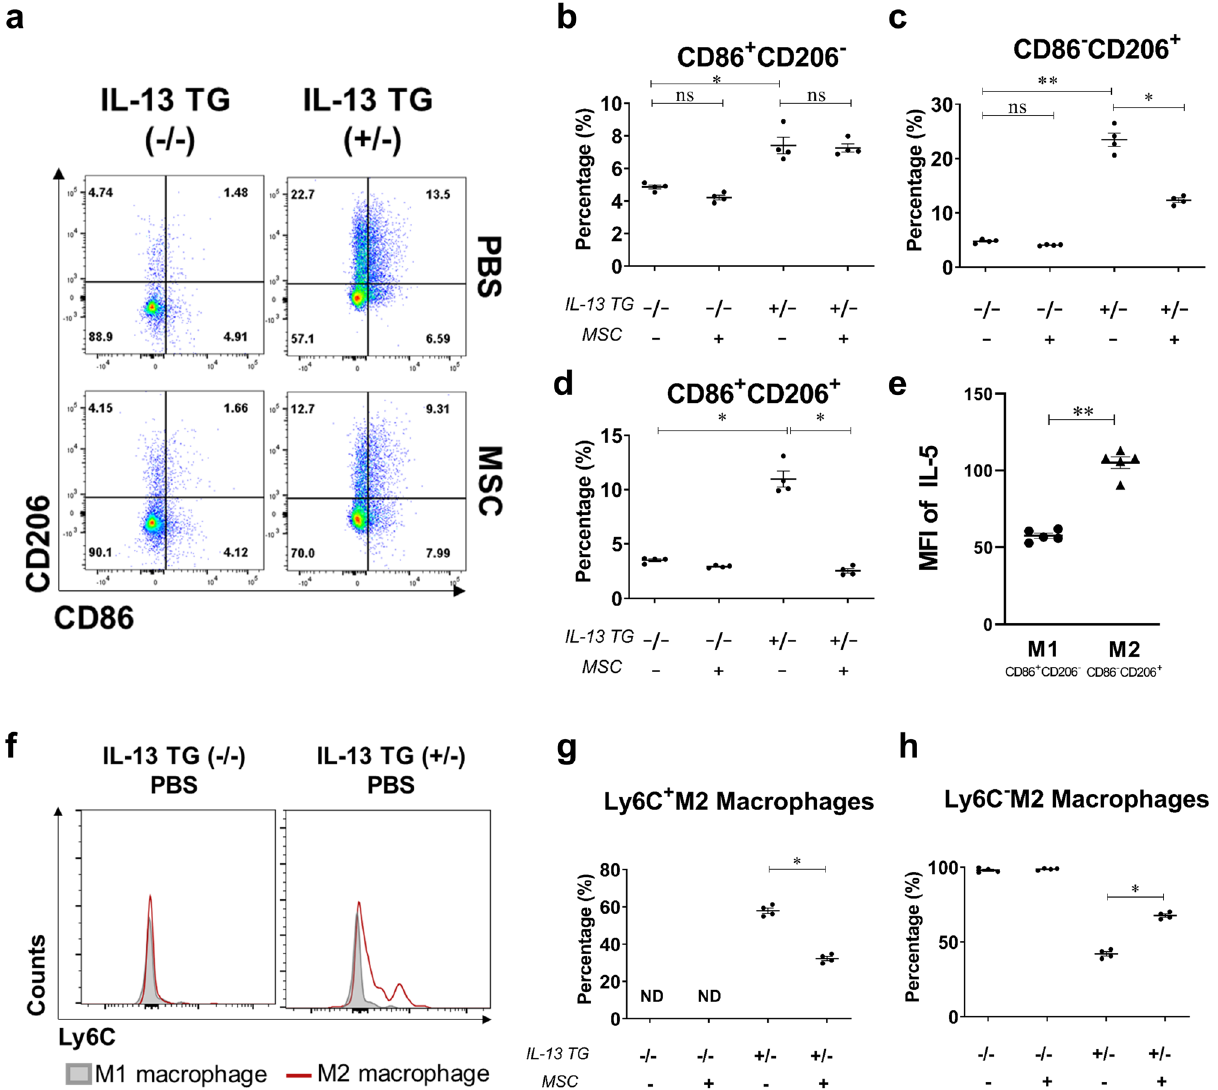
Figure 4. Ly6C + M2 macrophages are key mediators of asthmatic phenotypes. ( a ) Flow cytometric data on M1 and M2 macrophages of CD11c + CD11b + macrophages. The percentages of CD86 + CD206 − M1 ( b ), CD86 − CD206 + M2 macrophages ( c ), and CD86 + CD206 + macrophages ( d ) are represented in scatter plots. ( e ) the MFI of IL-5 in CD86 + CD206 − M1 and CD86 − CD206 + M2 macrophages in IL-13 TG mice. ( f ) Shows Ly6C expression levels in M1 and M2 macrophages of WT and IL-13 TG mice. ( g , h ) shows the ratio of Ly6C + M2 and LY6C − M2 macrophage populations among the CD11c + CD11b + macrophages. Flow cytometry data were analyzed by the FlowJo Software v10.6, https:// www. flowjo. com. Each value in these panels is from a different individual and the mean ± SEM are illustrated. All results are representative of at least three independent experiments. *p < 0.05, **p < 0.01, ns not significant. (by Kruskal–Wallis test using GraphPad Prism 7, https:// www. graph pad. Ly6C + M2 macrophages among CD11c + CD11b + macrophages are potential markers for asthma. Next, the polarization status of CD11c + CD11b + macrophages was assessed. To avoid a possible mis- leading interpretation, the F4/80 + CD11c + CD11b − alveolar macrophages were excluded, as they express surface markers for both M1 and M2 macrophages. CD86 + CD206 − M1, CD86 − CD206 + M2, and CD86 + CD206 + types of CD11c + CD11b + macrophages were upregulated in the disease control group. IL-13 TG mice that received hUC- MSCs showed reductions in M2 macrophages and CD86 + CD206 + populations (Fig. 4A–D). M2 macrophages expressed more IL-5 than M1 macrophages (Fig. 4E). It was found that neither M1 nor M2 macrophages from the healthy WT groups showed upregulated Ly6C expression. The disease groups, on the other hand, showed inflated Ly6C expression levels in the M2 macrophages, while showing no changes within the M1 macrophages (Fig. 4F). These results suggested that M2 macrophages adopt Ly6C expression under IL-13 enriched conditions. It was also found that the ratio of the Ly6C + M2 macrophages was significantly lower in the disease group treated with MSC injection than in the disease group without MSC injection (Fig. 4G–H), implying that the Ly6C + M2